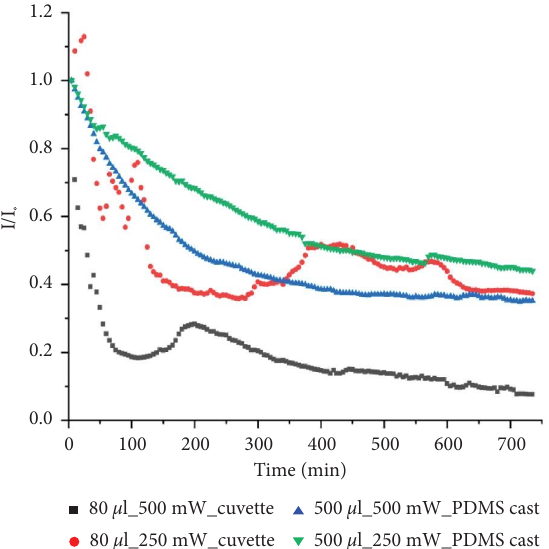
Figure 4: Photobleaching of 80 μ l of BSA sample in a static cuvette at 500 mW (black square) and 250mW (red circle) laser power and 500 μ l of BSA sample recirculated in a microfuidic device at 500mW (blue triangle) and 250mW (green triangle) laser power. Te intensities were expressed relative to the initial value as in Figure